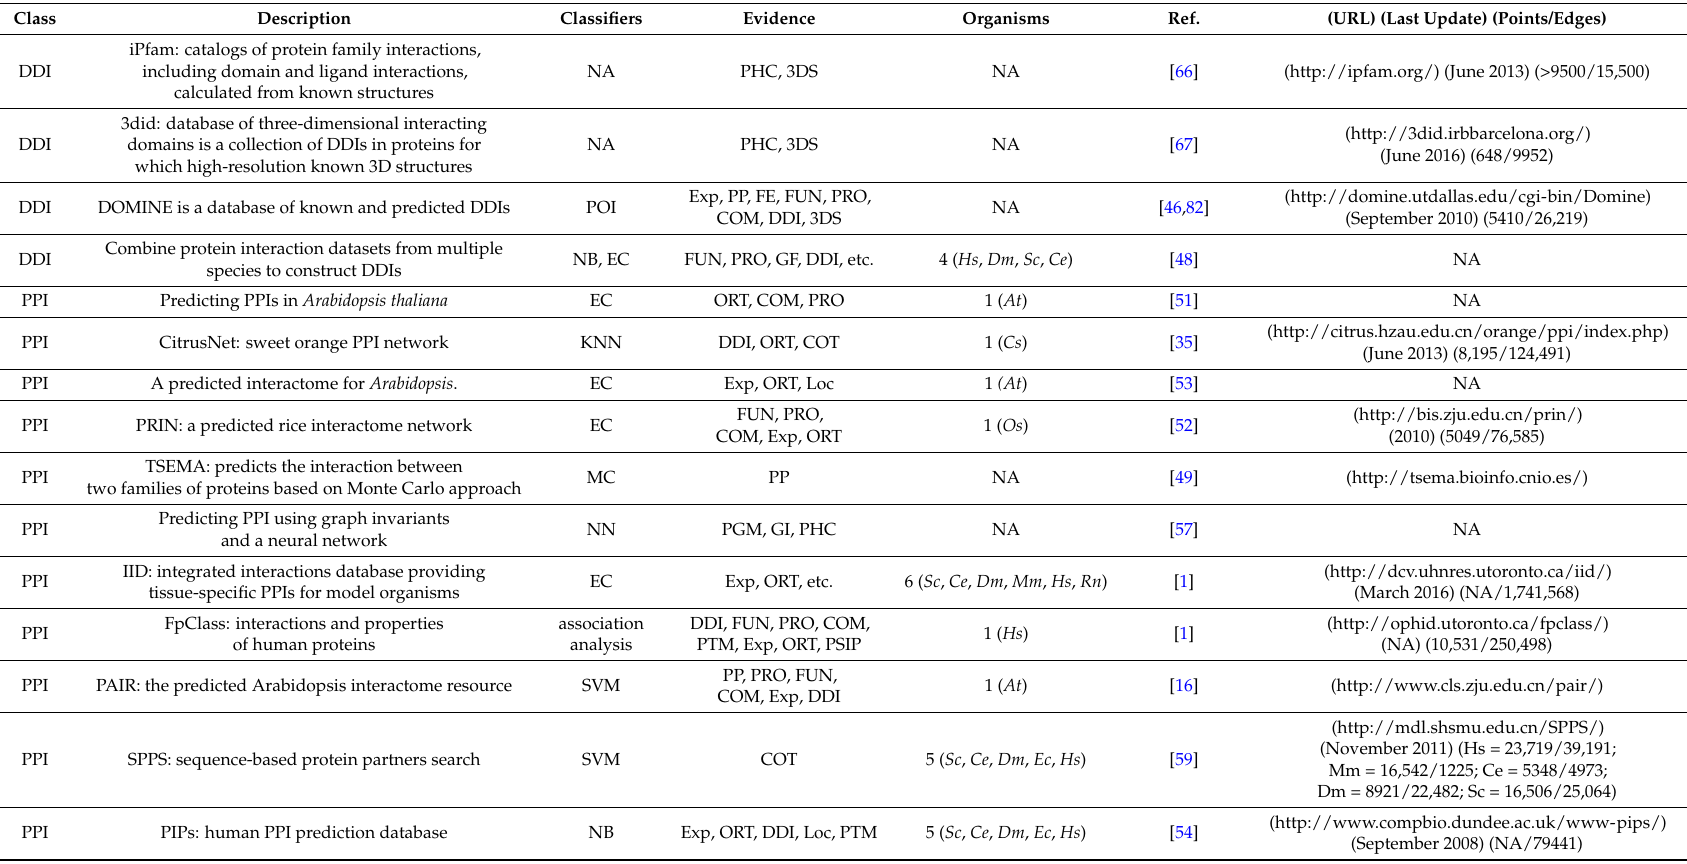
Table 3. Some studies or online tools of PPI prediction by evidence-combining methods (until September